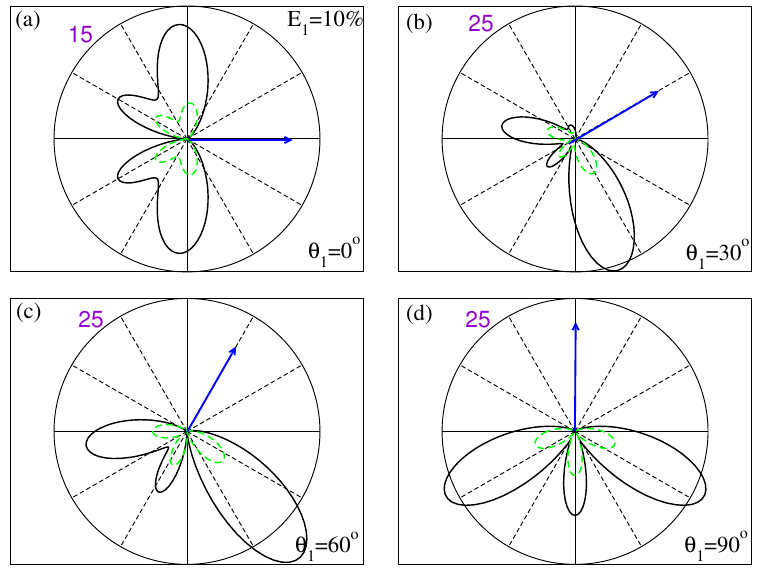
Figure 4. TDCS results for 3 P carbon (solid black line) at 10 eV excess energy and unequal energy sharing (fixed electron E 1 is 10% of the available excess energy). Results are plotted as in Figure 3. The purple numbers in each panel ( a – d ) indicate the magnitude of the cross-section (in b/(eV sr 2 ), establishing the radius of each circle. 1 b = 10 − 24 cm 2